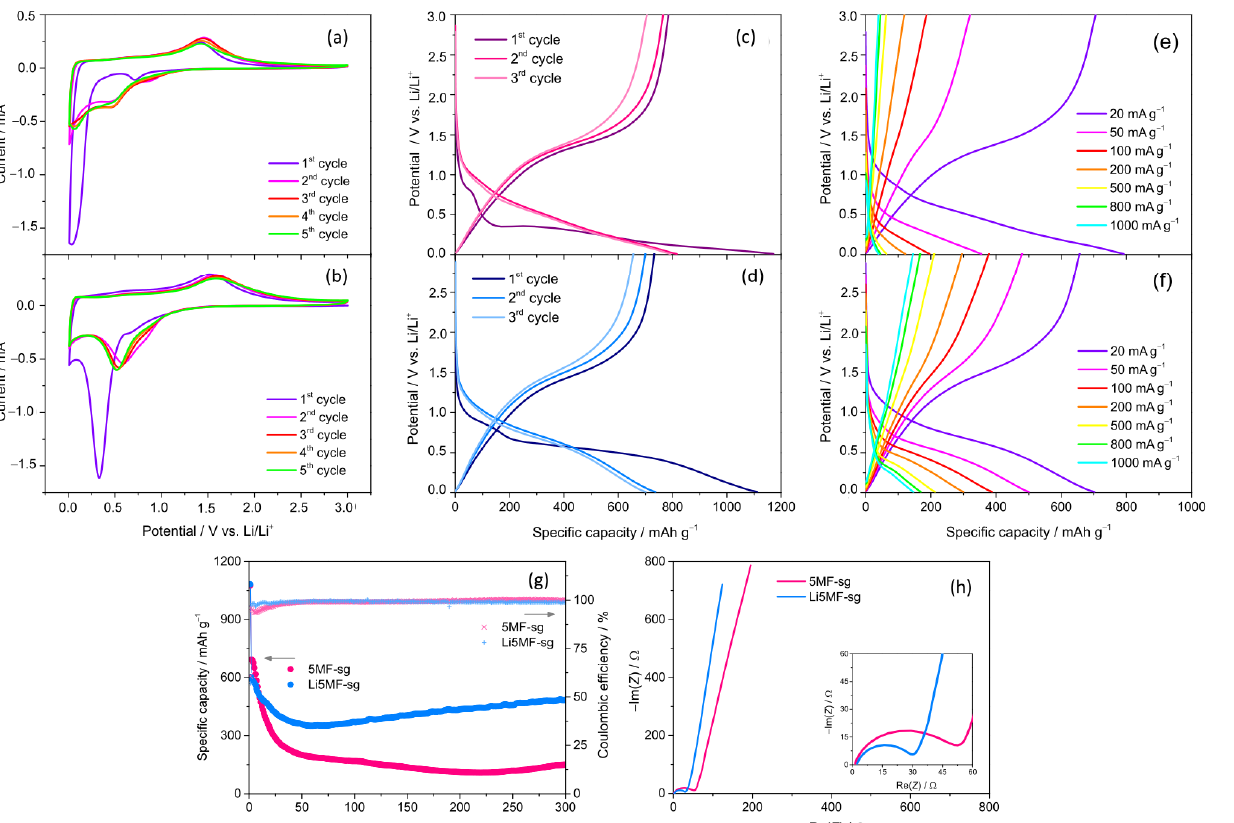
Figure 6. Electrochemical performance of samples ( a , c , e ) 5MF-sg, ( b , d , f ) Li5MF-sg in Li-ion half cells. ( a , b ) CV curves (scanning rate of 0.1 mV s − 1 ), ( c , d ) galvanostatic charge–discharge curves measured at 20 mA g − 1 and ( e , f ) galvanostatic charge–discharge curves measured at different current density. ( g ) Cycling stability at a current density of 500 mA g − 1 and ( h ) results of EIS measurements.